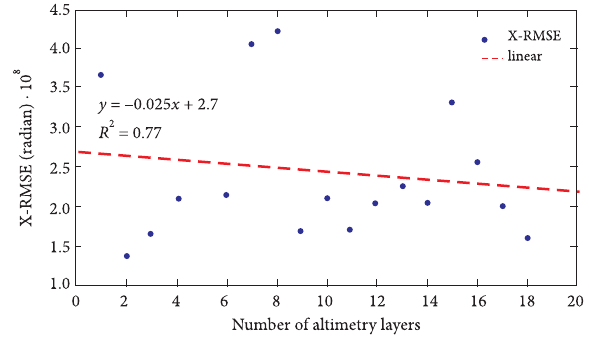
Fig. 3. The study area imaged by Cartosat-1 satellite imagery Fig. 4. RMSE (Longitude) changing rate